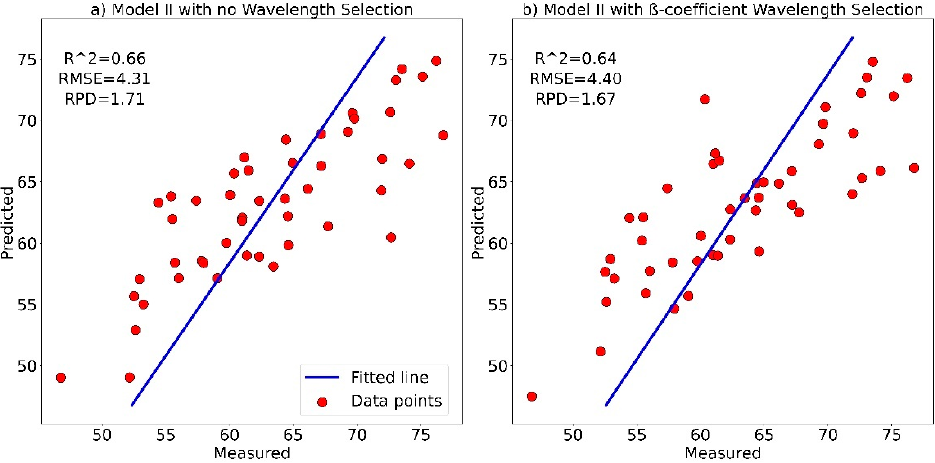
Figure 6. Measured vs. predicted moisture content in the case of selected optimum wavelengths using PLSR regression.